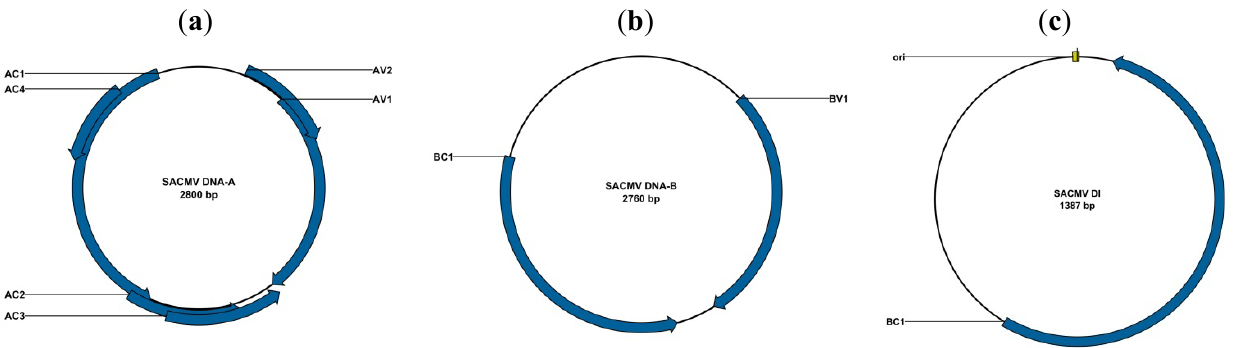
Figure 2. Genome organizations of ( a ) South African cassava mosaic virus (SACMV) DNA A component; ( b ) SACMV DNA B; ( c ) SACMV defective interfering molecule